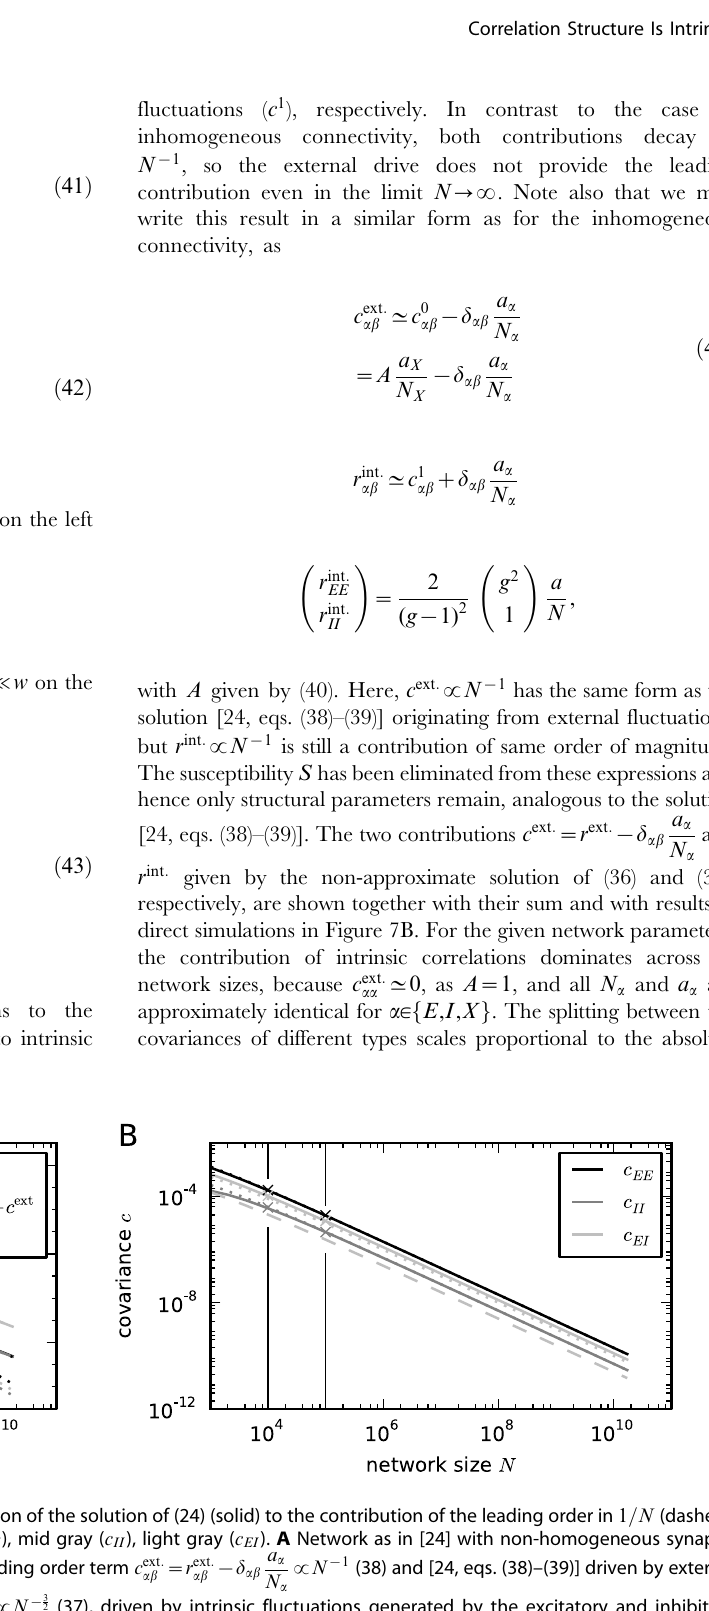
PLOS Computational Biology |